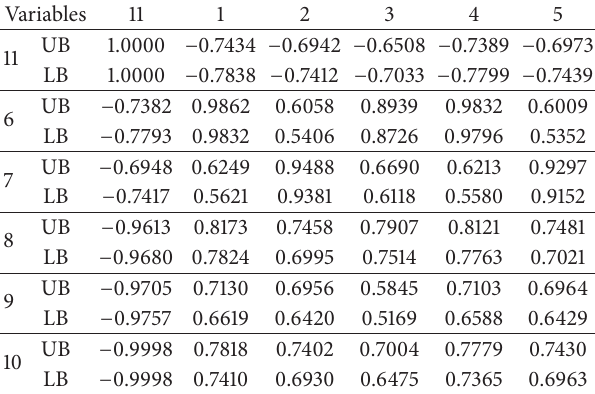
Table 2: Lower and upper bound related to Table 1.